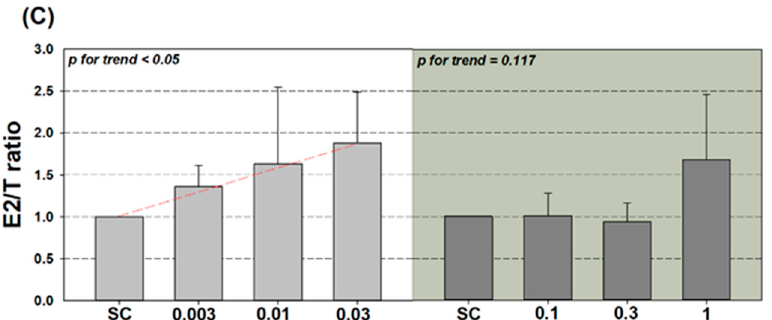
Figure 3. Effects on sex hormones of ( A ) 17 β -estradiol (E2), ( B ) testosterone (T), and ( C ) E2/T ratio in H295R cells exposed to DBDPE and BTBPE. The results are shown as mean ± SD of triplicates ( n = 3). Asterisk indicates a significant difference relative to the solvent control (0.1% DMSO, p < 0.05). The value of p for trend was determined based on the linear regression analysis. If p for trend was <0.05, a linear trend is indicated with a red dotted line.